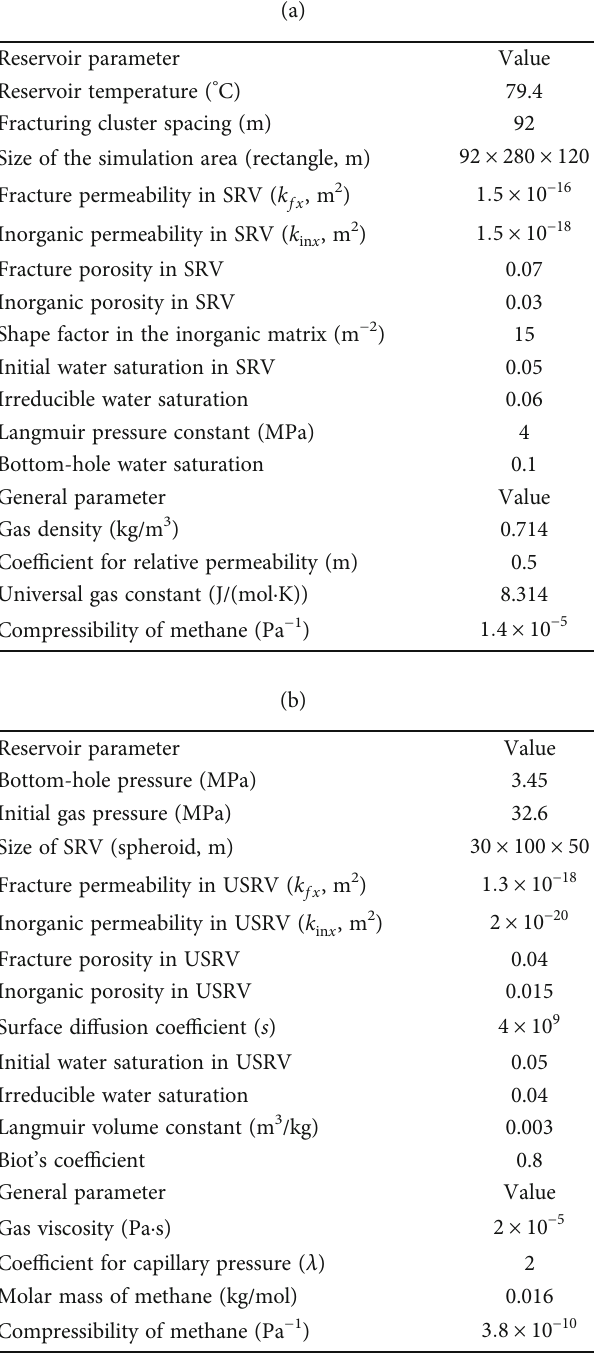
Table 1: Marcellus Shale property parameters [66, 67].